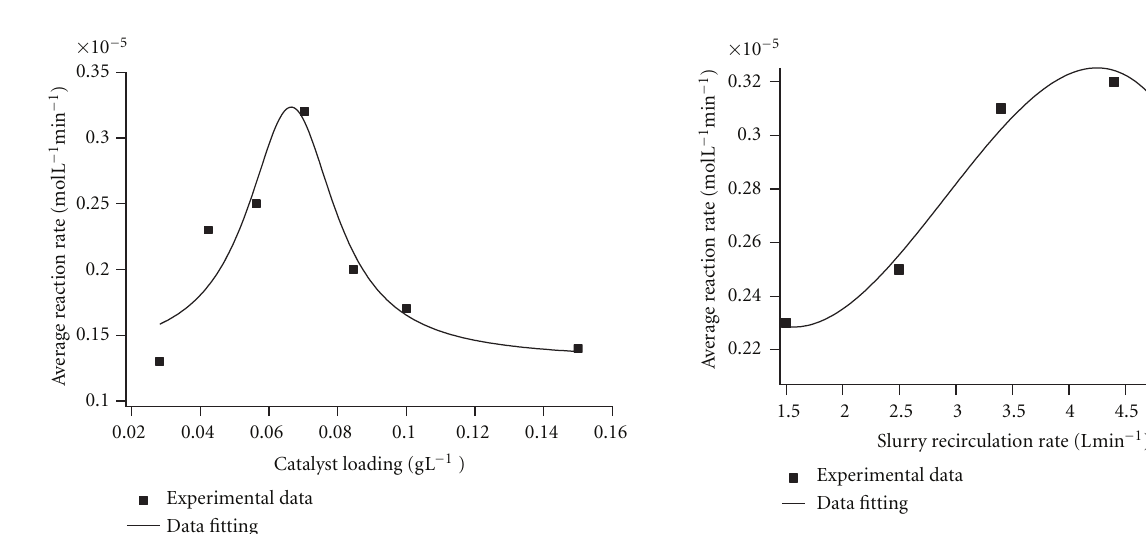
Figure 7: E ff ect of slurry recirculation rate on average reaction rate (TOC initial concentration = 24 . 62 ± 0 . 44 mgL − 1 , average reaction temperature = 27 ◦ C, initial slurry pH = 3 . 00,0 . 07 gL − 1 catalyst loading and 1.8 Lmin − 1 air flow